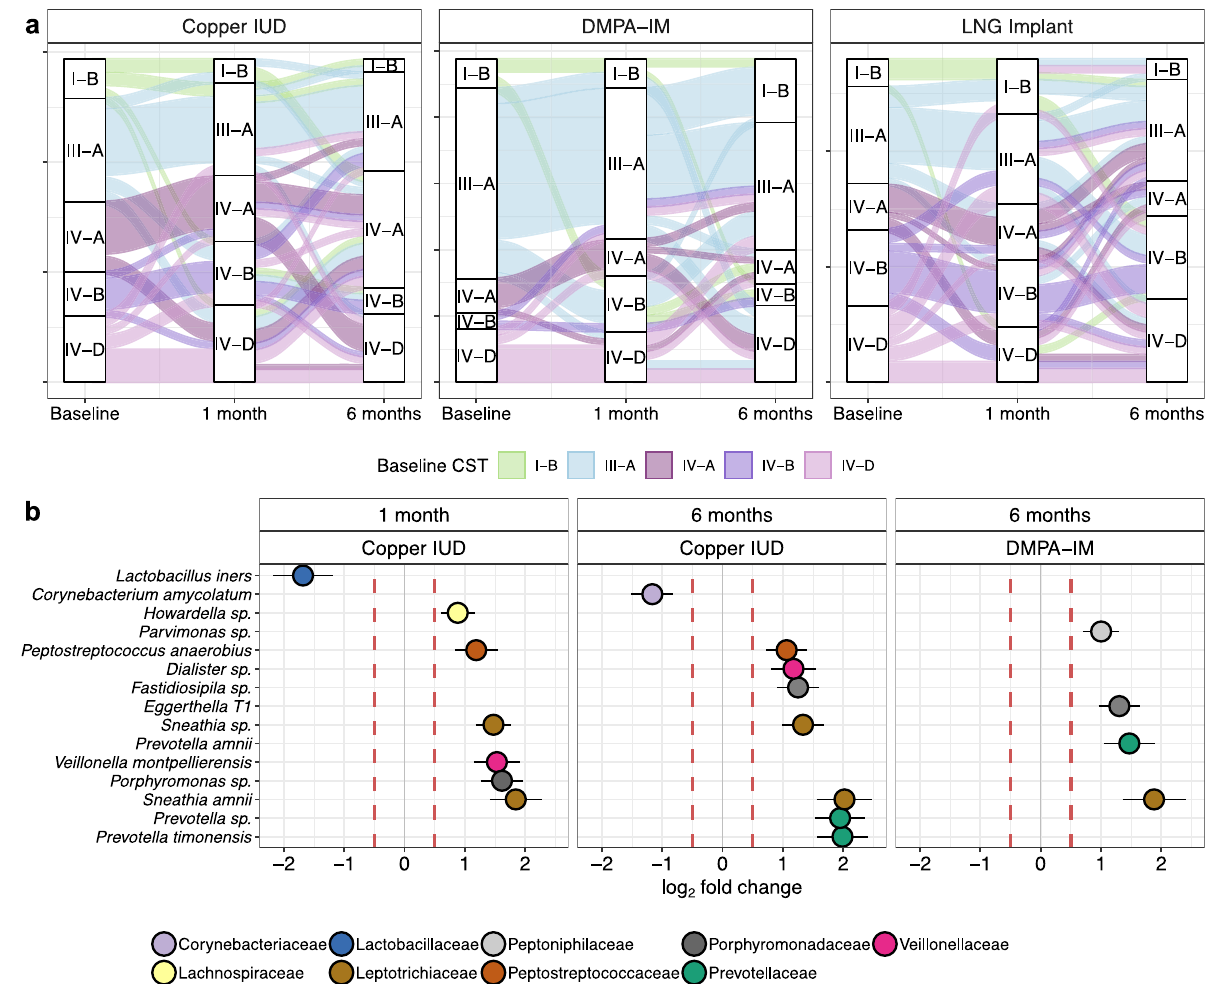
Fig. 2 | Contraceptive use drives CST transition and shifts in bacterial abun- dance.a CSTsareindicatedateachtimepointandalluvialstracktheprogressionof a given participant across time. Plots are faceted by randomization arm. b Fold changes in bacterial abundance after 1 and 6 months of contraceptive use, relative to enrollment abundance. Fold changes are log 2 transformed and were calculated